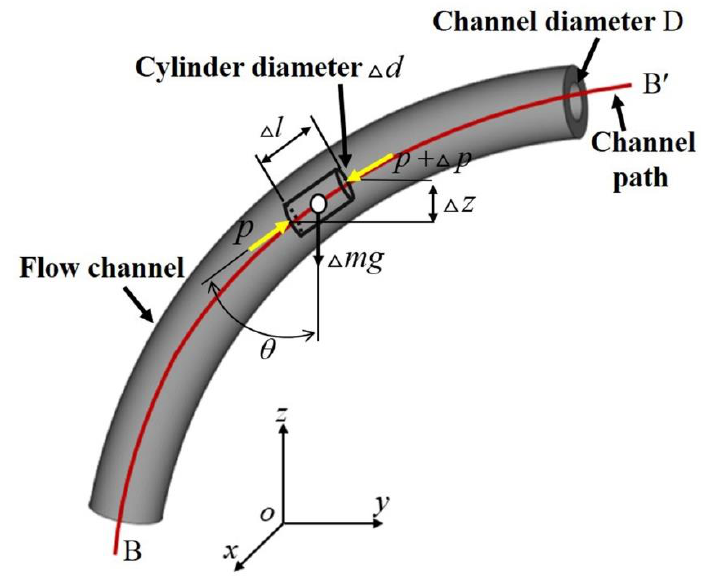
Figure 2. Flow channel pressure loss analysis.